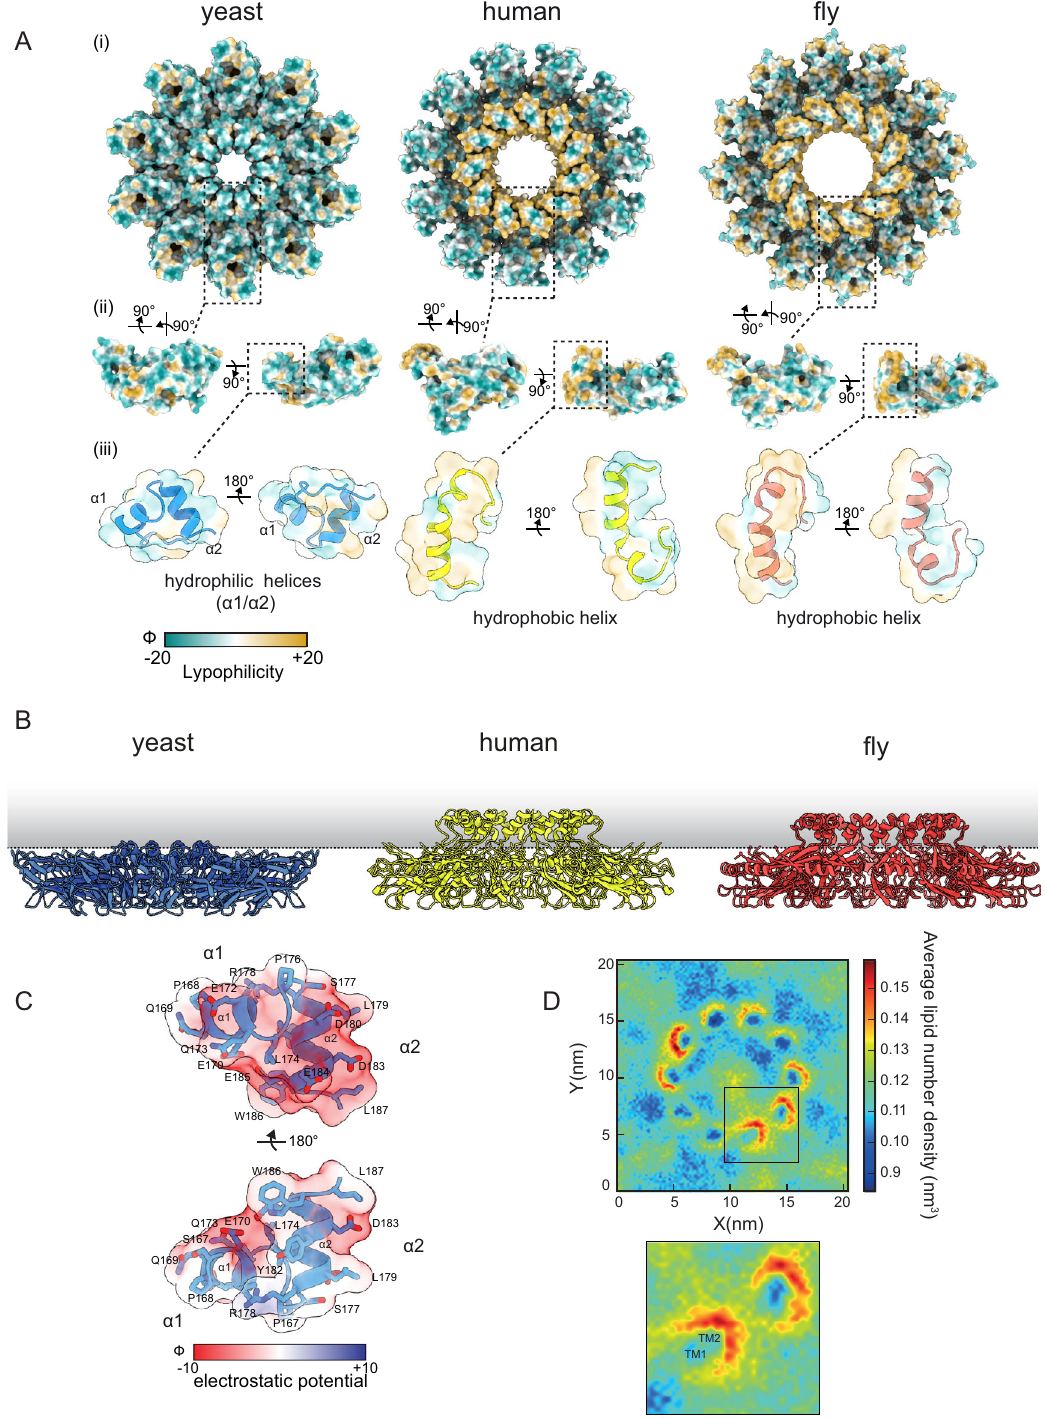
Fig. 2 The Sei1 luminal domain lacks a hydrophobic central helix and the ability to concentrate TAG. A Lipophilicity potential mapped to surface representations of yeast (left), human (middle), and fl y (right) as viewed as (i) homodecamer assembly from the cytosol, (ii) individual protomers, or (iii) transparent overlay over zoomed in cartoon representation of the central α 1- α 2 helices. Surfaces are colored from hydrophilic (dark cyan) to hydrophobic (gold). Lipophilicity potential was generated from the mlp command of ChimeraX. B Side view of the luminal domains of yeast, human (PDB 6DS5) and fl y (PDB 6MLU) Seipin in relation to the plane of the ER membrane (indicated by a dotted line). C Charge distribution of the yeast Sei1 central helices ( α 1, α 2), depicted as a transparent Coulombic electrostatic potential surface representation (Red, negative charge; blue, positive charge; white, no charge) overlayed over a cartoon representation (light blue) to show acidic side chains. Electrostatic potential was generated from the coulombic command of ChimeraX. D Top View of coarse-grained MD simulations of Sei1 in a POPC membrane with 3% trioleylglycerol. Images depict average lipid number density of trioleylglycerol. Inset – zoom in of corresponding box showing positions of TM1 and